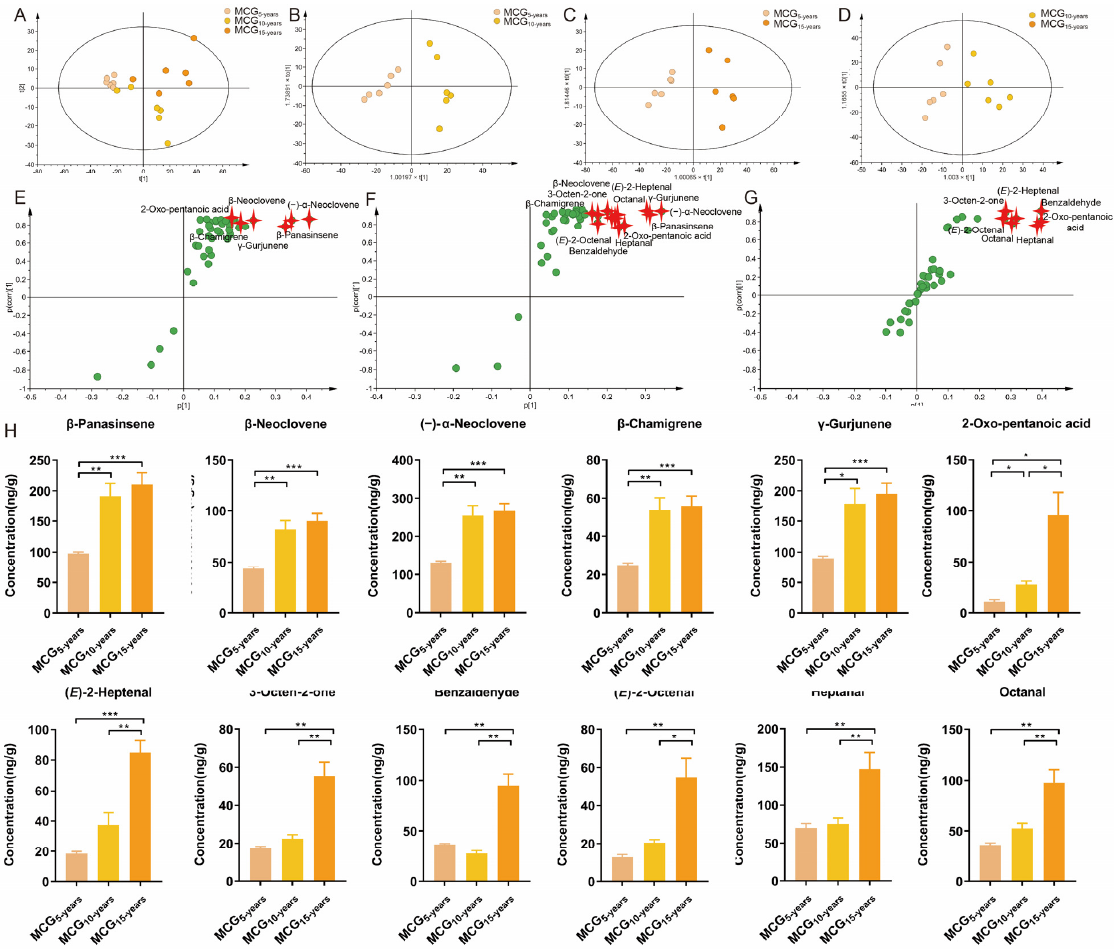
Figure 3. Multivariate statistical analysis based on volatile components from MCG with 5-,10-, 15-growth years ( A ) PCA score plots; ( B – D ) OPLS-DA score plots; ( E – G ) S-plots; ( H ) The